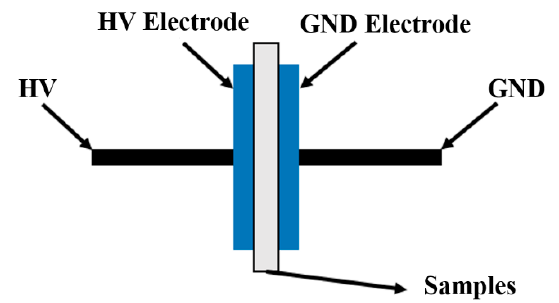
Figure 4. The electrodes on Dielectric AC breakdown test.